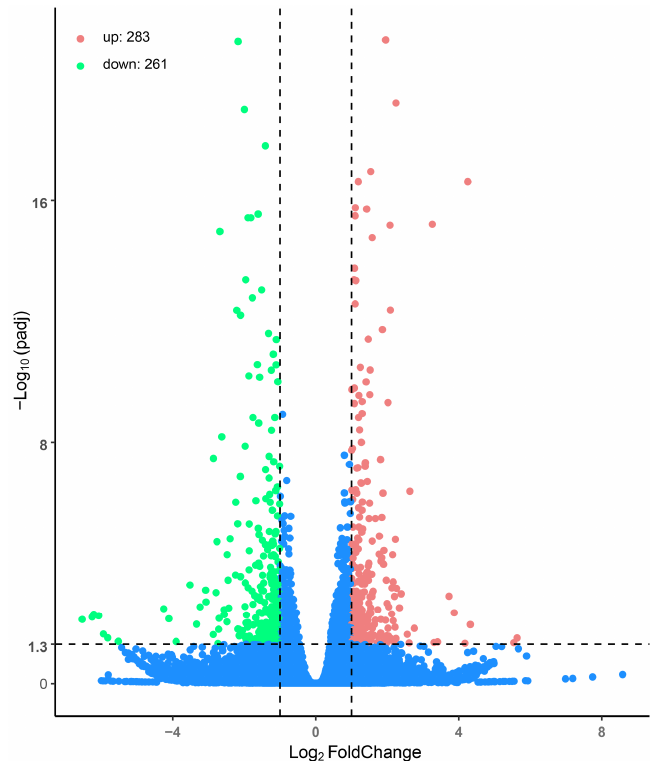
Figure 3. Volcano plot of differentially expressed genes (DEGs) in the clam Meretrix meretrix between the control and treatment groups. Red dots represent up-regulation after treatment; green dots represent down-regulation after treatment. DEGs were identified by Log 2 |fold change| > 1 and p -value ( padj ) < 0.05.